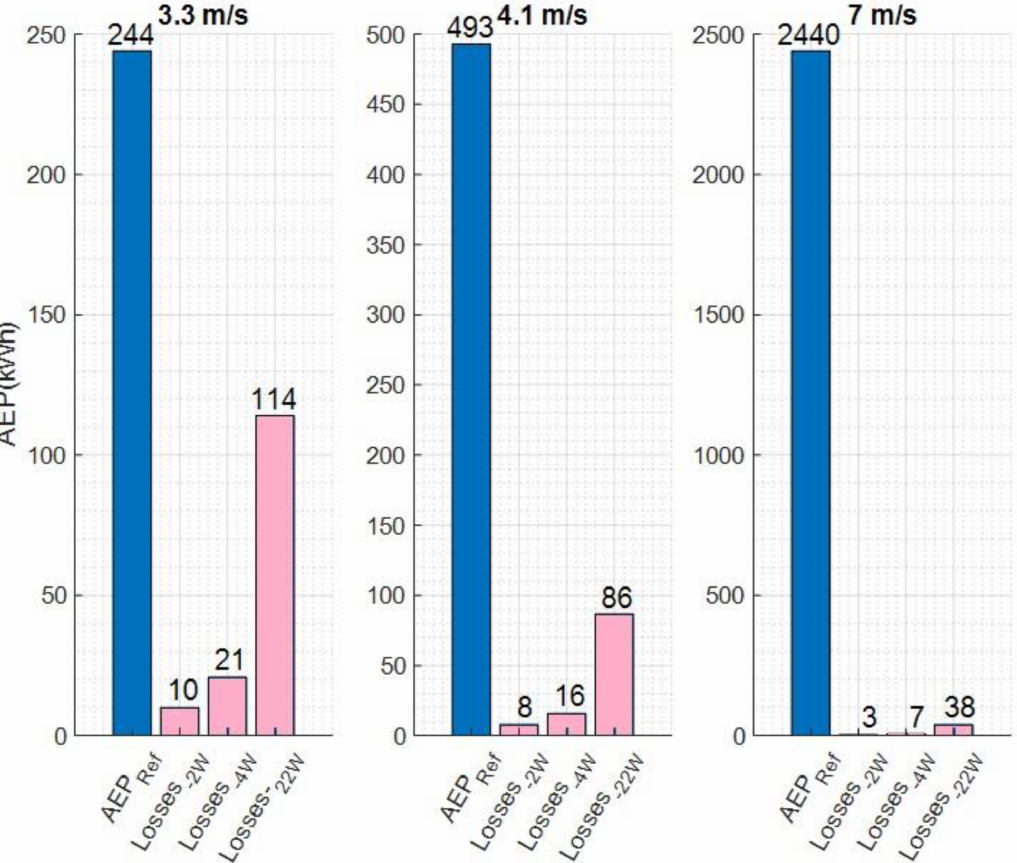
Figure 15. Annual Energy Production (AEP) for 3 sites with different annual mean wind speed ( left = 3.3m/s, middle = 4.1m/s, right = 7m/s) assessing the losses for 3 different inverter standby losses (2, 4, and 22 W) compared to the reference